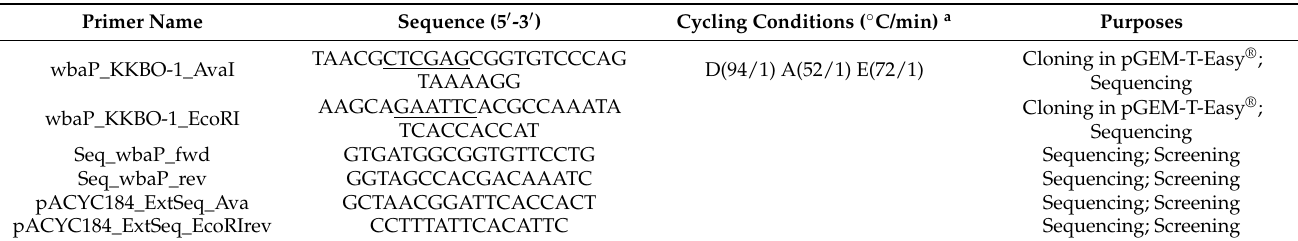
Table 1. List of primers and PCR conditions used in this work. Endonuclease restriction sites added for cloning purposes in some primers are